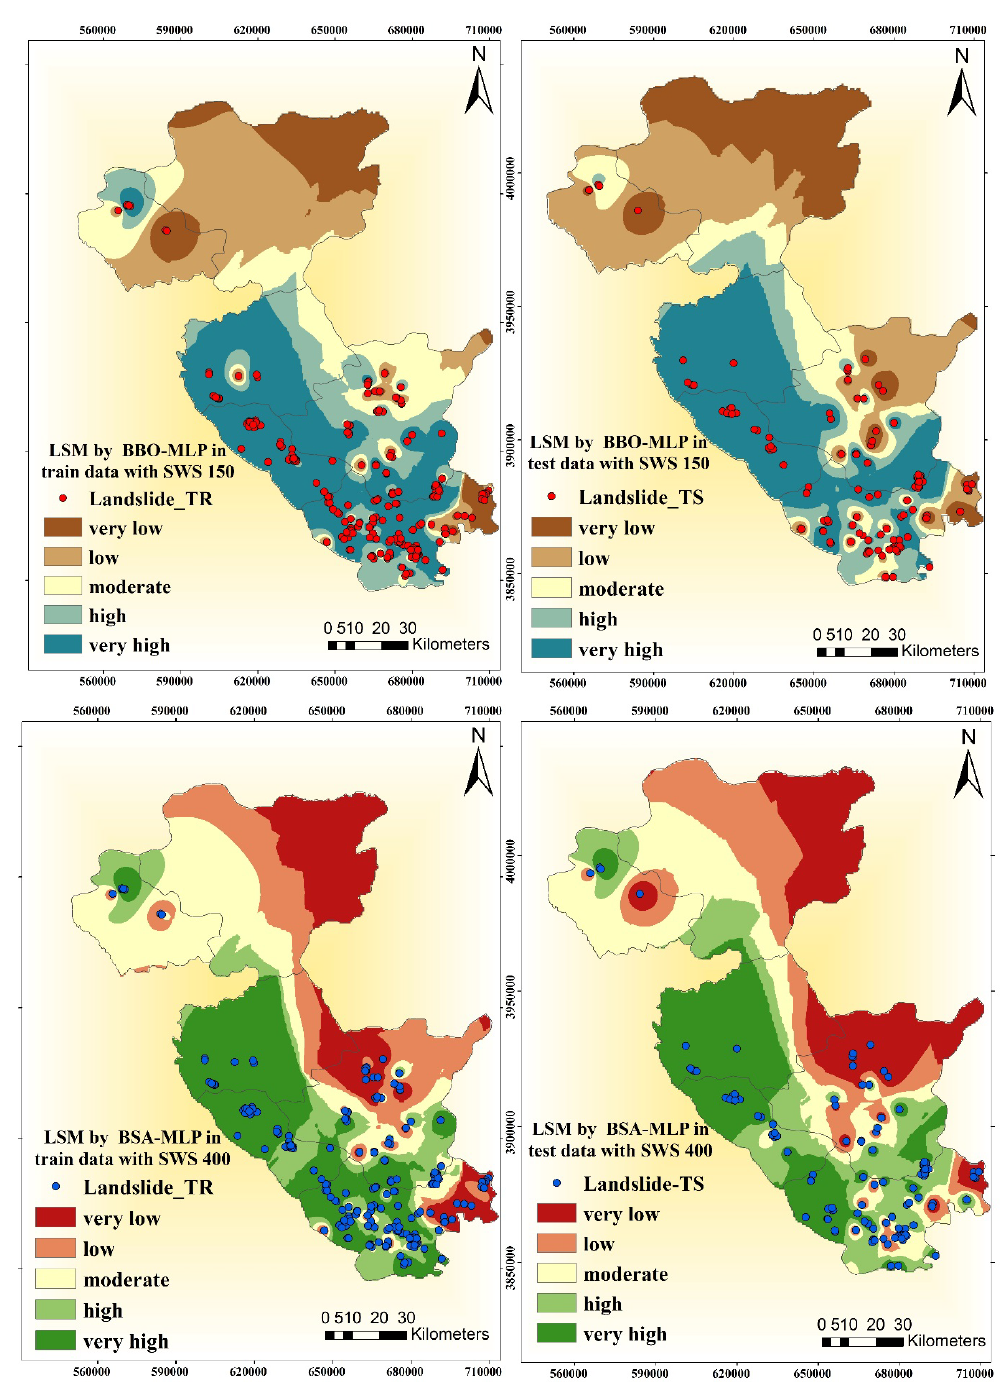
Figure 13. The final landslide susceptibility mapping using both BBOMLP and BSAMLP.